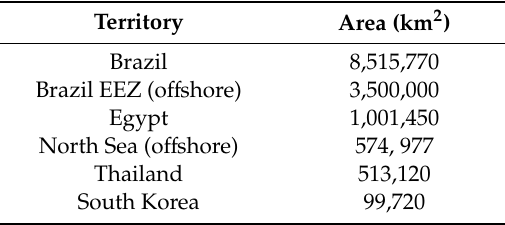
Figure 8. Flow-chart representation of the methodology. Table 2. Territory areas investigated in studies that apply multicriteria analyses as a methodology for potential o ff shore wind